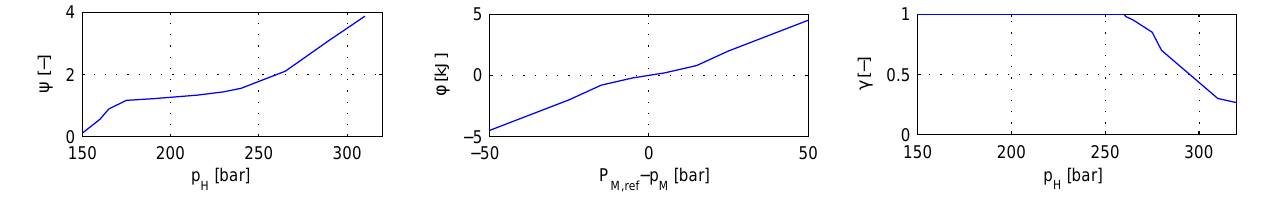
Figure 25. Maps for the different system control parameters, ψ , ϕ and γ